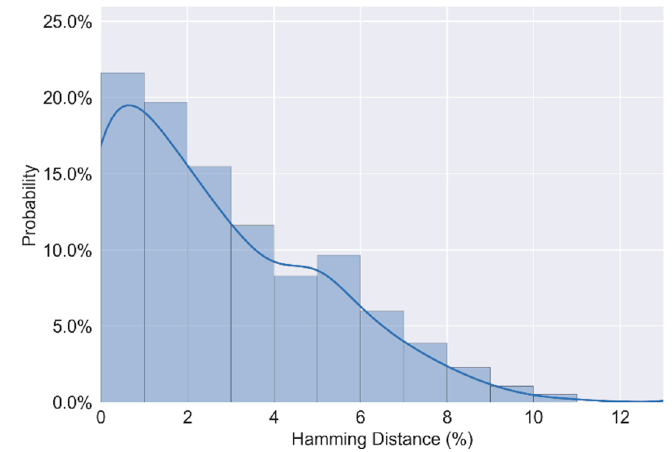
Figure 12. Reliability of responses.